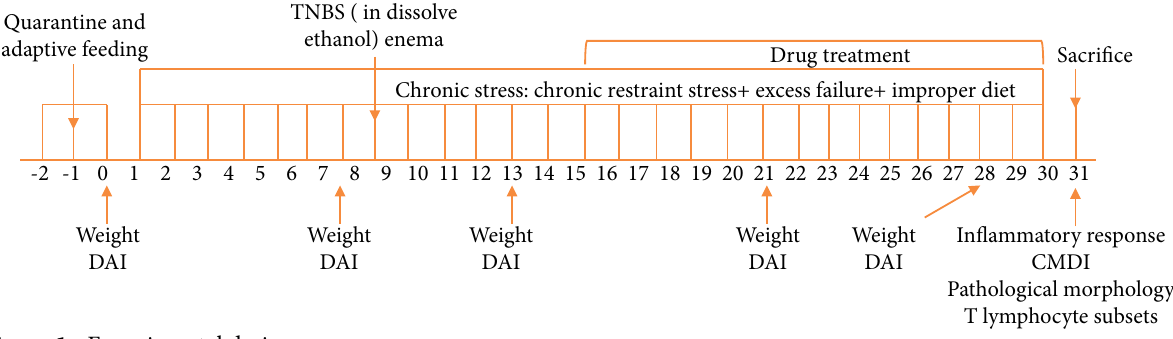
Figure 1 - Experimental